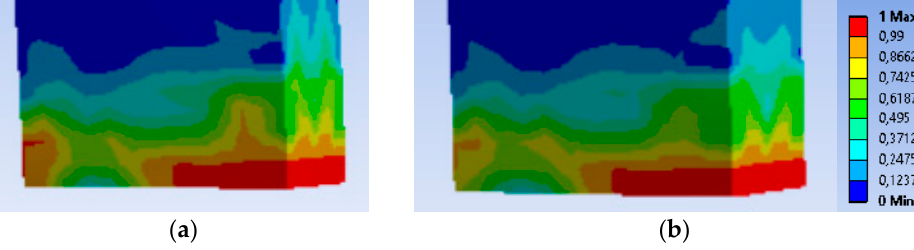
Figure 6. Concrete damage of specimens ( a ) NS-X0; ( b ) NS-X16.